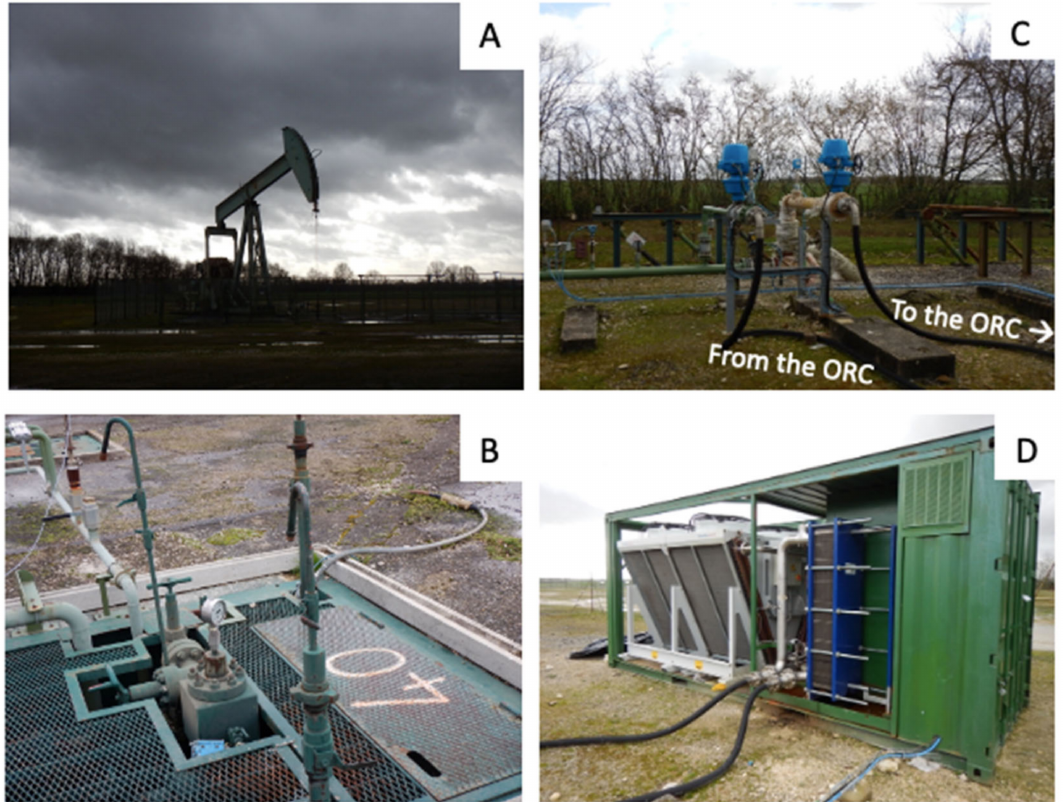
Figure 2. The small-scale mobile Organic Rankine Cycle (ORC) unit installed at Chaunoy oil field. ( A ): one of the oil wellheads, ( B ): head of the CNY40 well from which the oil and hot water are extracted, ( C ): the connection of the hot water pipe to the ORC unit, ( D ): the mobile ORC unit connected to the water pipe. The samples tested at Chaunoy in this work were placed within the inlet of the ORC unit during a 4-month